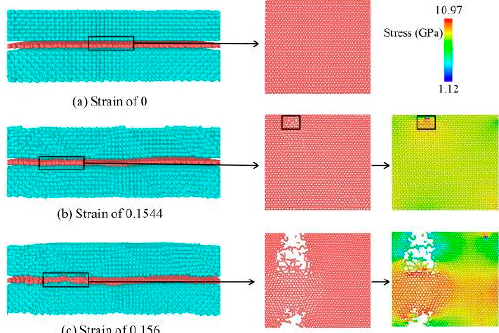
Figure 4. Fracture process and stress distribution of PGC under uniaxial tensile loading at the temperature of 300 K. ( a ) ε = 0 before the load is applied. ( b ) ε = 0.1544 before reaching the stress limit. ( c ) ε = 0.156 after Fracture Failure.